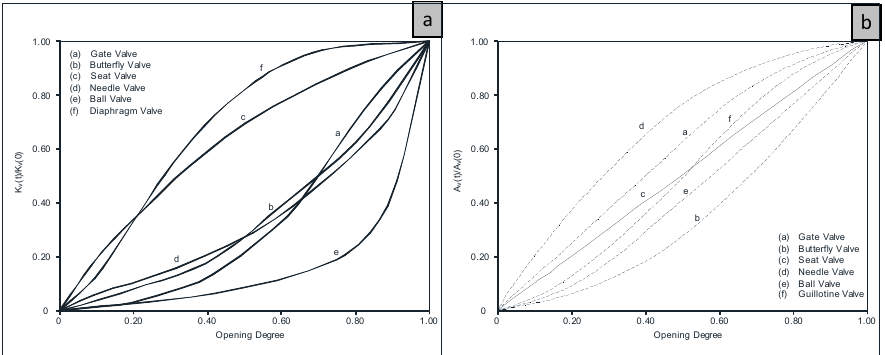
Figure 1. Valves manoeuvres. ( a ) type of loss coefficients and ( b ) opening cross area depending on the type of valve and the opening degree.